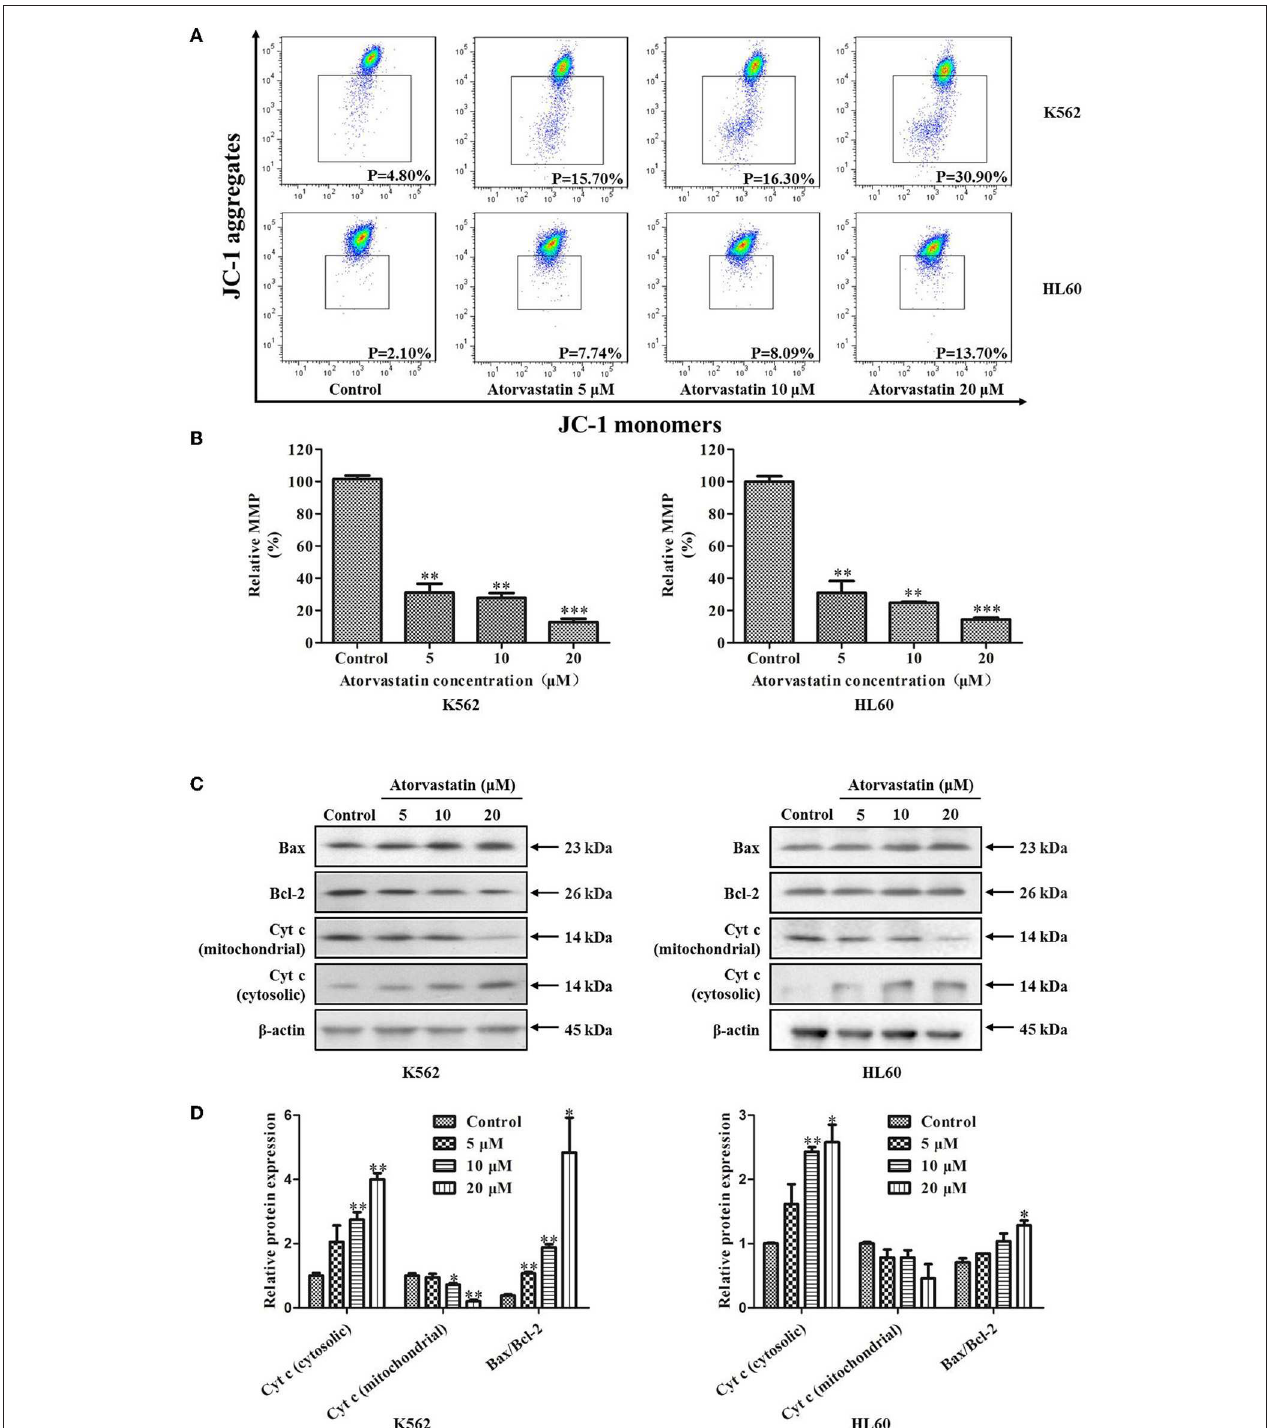
FIGURE 5 | Atorvastatin induces loss of MMP in K562 and HL60 cells. K562 and HL60 cells were incubated with Atorvastatin (0, 5, 10, and 20 µ M) for 24h. (A) MMP was examined by flow cytometer and the data were analyzed using Flow Jo Software. The representative images were shown. (B) The percentages of relative MMP were shown and statistically analyzed. (C) The levels of Bcl-2, Bax, and Cytochrome c (Cyt-c) were determined by western blot. (D) Bar graphs show the relative levels of Bcl-2, Bax, and Cytochrome c . Data are presented as mean ± SD of three independent experiments. * p < 0.05, ** p < 0.01, *** p < 0.001 vs. control.